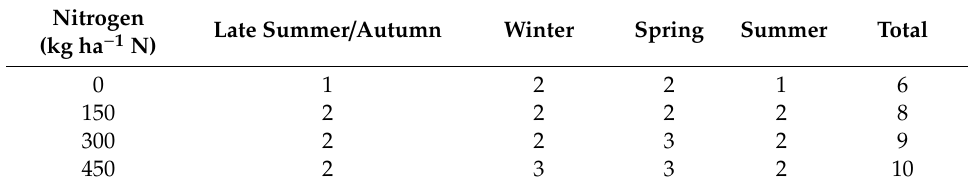
Table 2. Number of grazing cycles of grass pastures Brachiaria brizantha cv. Piat ã under rotational stocking and fertilized with nitrogen throughout seasons of the